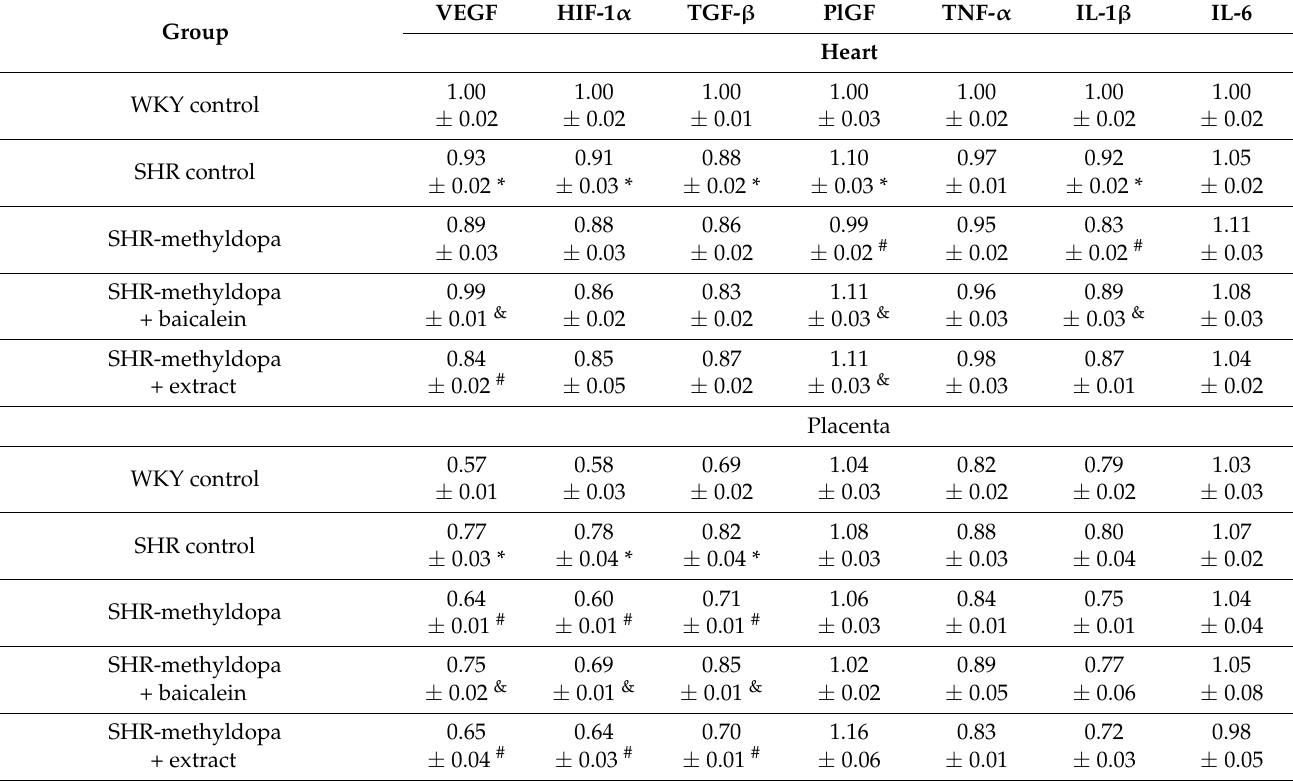
Table 1. Influence of methyldopa, its combination with baicalein or extract from Scutellaria baicalensis roots on mRNA level changes of cardiovascular factors (VEGF, HIF-1 α , TGF- β , PlGF) and inflamma- tory processes (TNF- α , IL-1 β , IL-6) in tissues of SHR pregnant rats. The numerical values represent the changes in the level of fluorescence for individual genes measured in the qPCR reaction, where the value 1—was the reference level for the referential